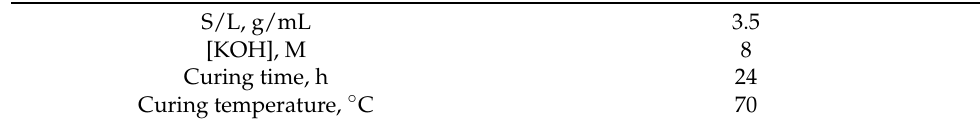
Table 2. Experimental conditions of compact geopolymer material (Geo). S/L, g/mL 3.5 [KOH], M Curing time, h 24 Curing temperature, ◦ C 70